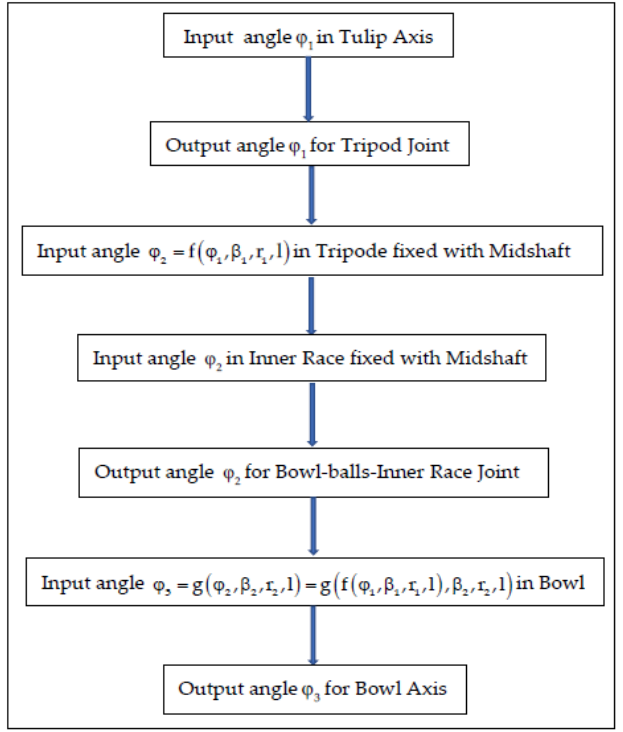
Figure 9. Flow chart of a quasi-isometric CVJ automotive driveshaft.